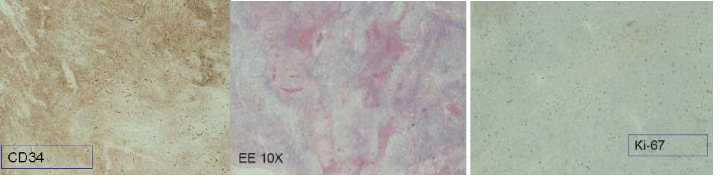
Figure 1. Immunoistochemistry analysis of mSFTP. Coloration for CD34, Ki-67 and Hematoxylin eosin 10X eosin Vimentin and cytokeratin (AE1-3) were found in four (11.7%) and two (5.8%) patients respectively.